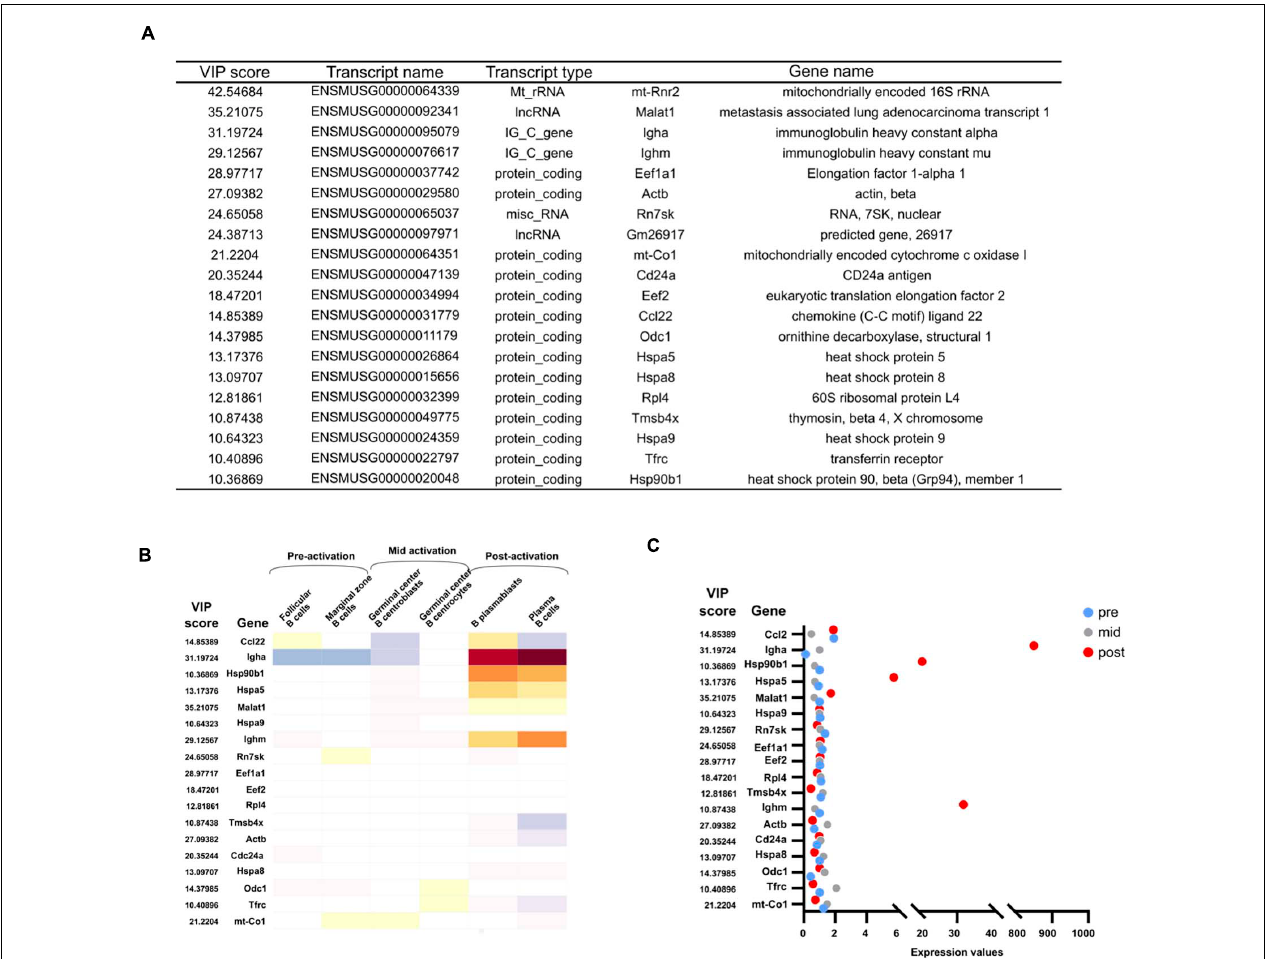
FIGURE 5 | VIP transcript list and their expression in vivo . (A) The 20 transcripts with the highest Variable Importance in Projection (VIP) scores. (B) Expression of VIP genes in vivo . Median normalized gene expression values in different B cell subsets in vivo as annotated in Immunological Genome Projects. Further subclassified into pre-, mid-, and post-activation correlating to activation for CSR in CH12F3. (C) Quantification of normalized expression values of VIP genes in the dot